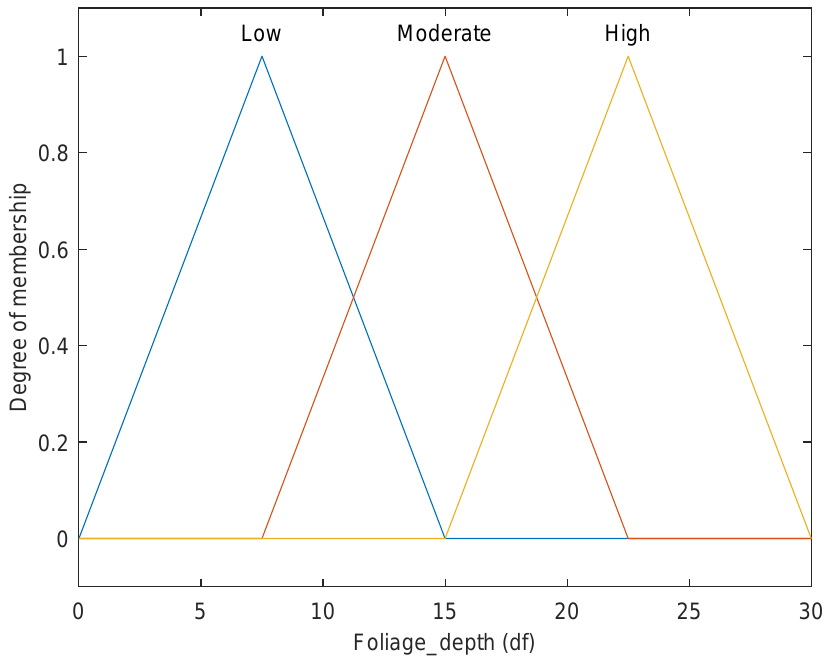
Figure 5. Membership function (MF) plot for input variable foliage depth ( d f ).